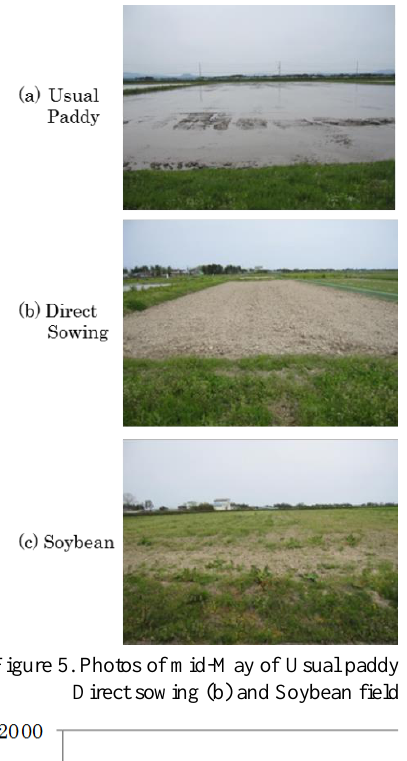
Figure 5. Photos of mid-May of Usual paddy (a), Direct sowing (b) and Soybean field (c)